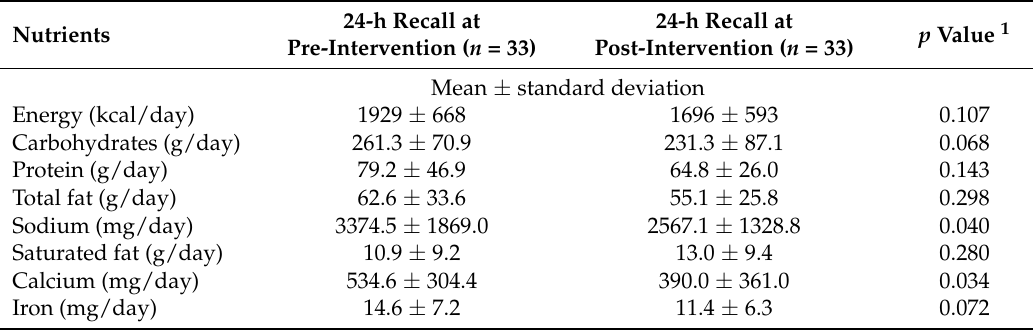
Table 3. Comparison of the nutrient intake from pre- and post-24-h recalls among all male and female students ( n =